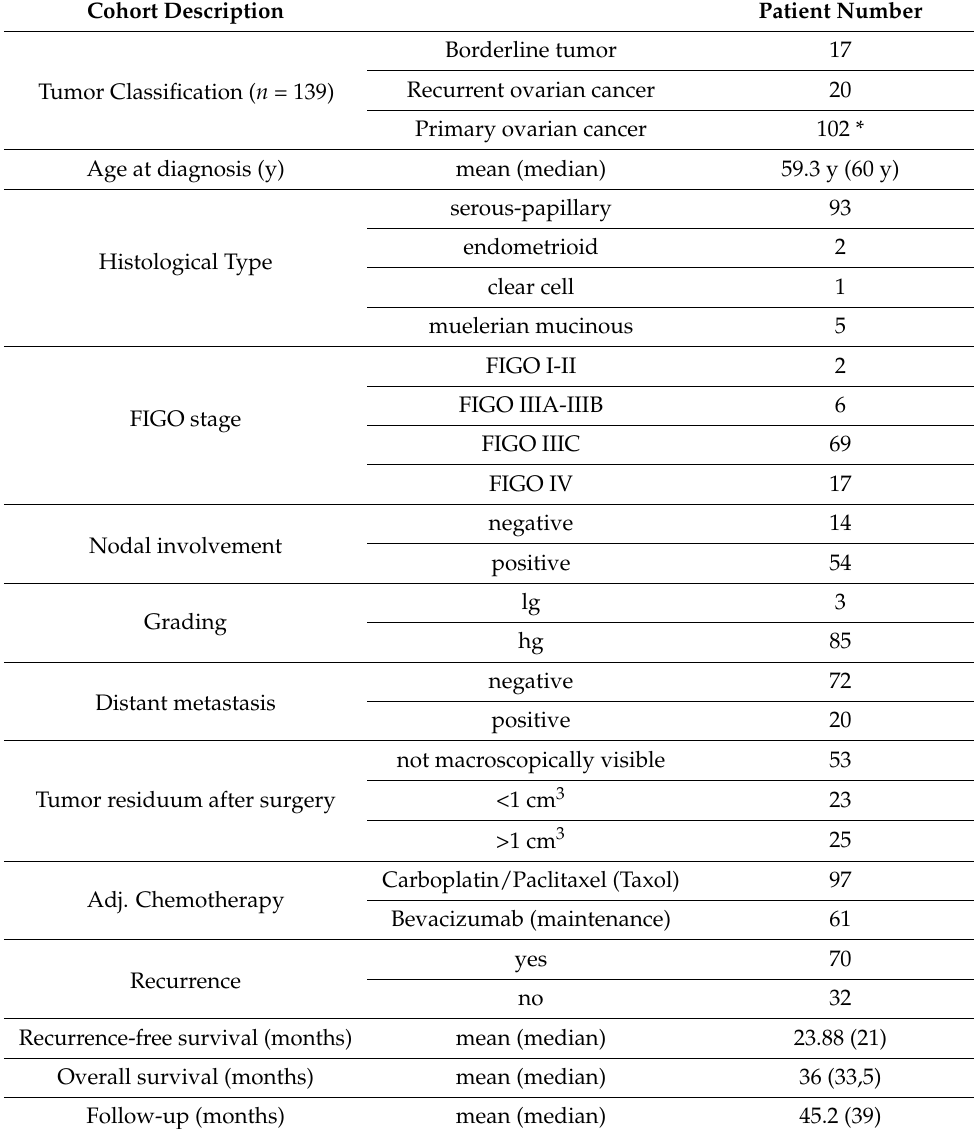
Table 1. The clinical and histological characteristics of the primary